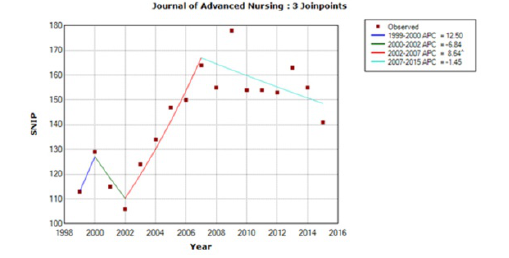
figure should be: Figure 3 Trend model for the Journal of Advanced Nursing (JAN)